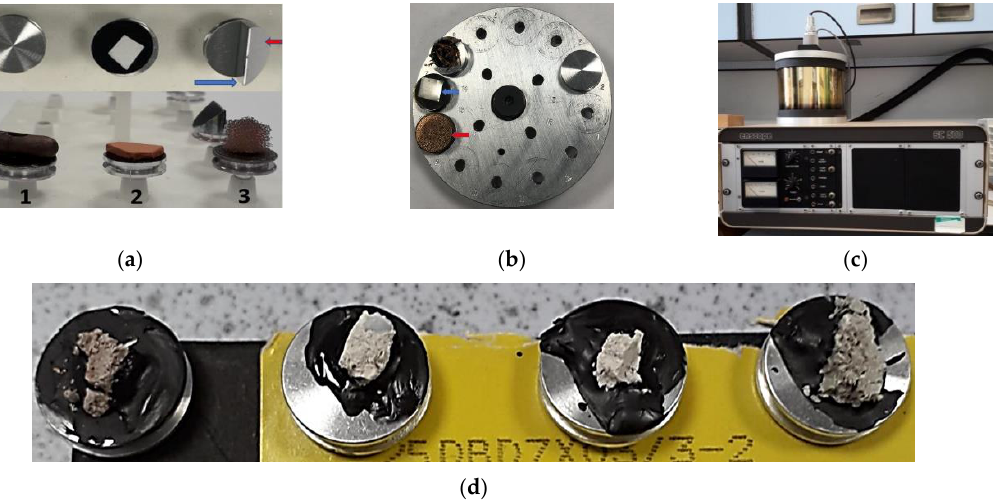
Figure 7. ( a ) (1) Samples are mounted on standard aluminum stubs 13 mm in diameter. The stub has a groove at the side to facilitate handling using forceps; (2) the aluminum stub with a double-sided adhesive black conductive carbon, tab. A, piece of filter paper has been cut to size and pressed down at the corners using forceps onto the tab; (3) this stub allows one to see a transverse view. The sample is mounted against the vertical face (blue arrow). The red arrow indicates a 45 ◦ angle face. ( b ) The stub holder for the SEM chamber. The blue arrow indicates a piece of metal that requires no further preparation. The red arrow shows a non-conductive sample that has been sputter coated with gold to make it conductive; ( c ) gold sputter coating unit; ( d ) treated artificially-synthesized subgrade (ASS) samples mounted and ready for the SEM and EDX analysis .